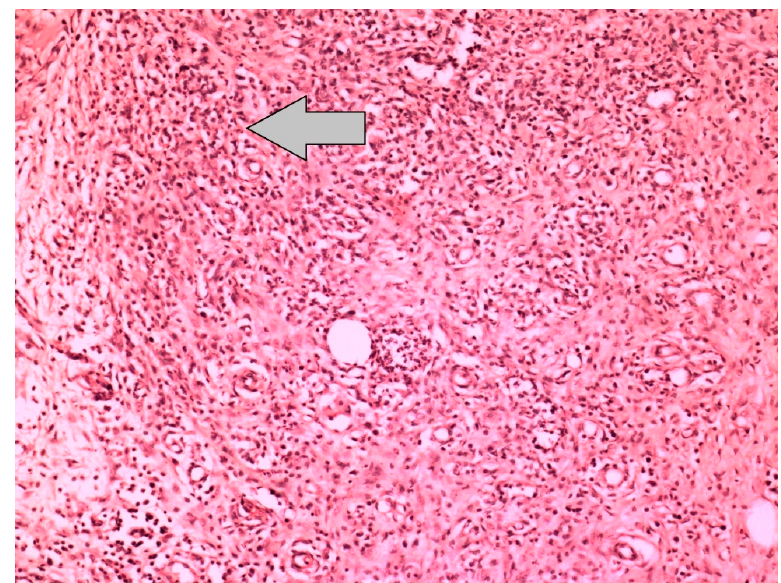
Figure 4. Histopathological image, which represents the grade 4 inflammation at the anastomotic line of the Sham-I group, shows the neutrophil-rich dense inflammatory cell infiltration and capillary vessel proliferation in the colon anastomosis region (H&E × 100).